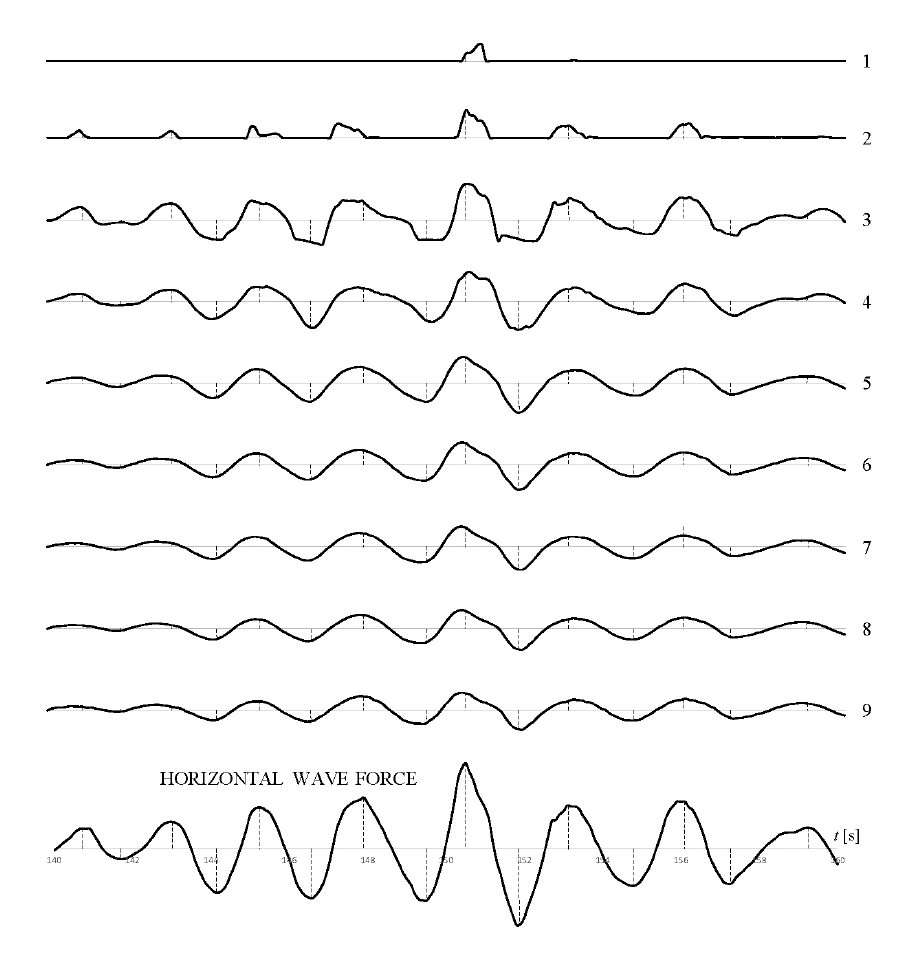
Figure 4. Wave pressure p wi , recorded at various depths on the central caisson of the U-OWC breakwater (see Figure 2a for the gauge map), and the horizontal force obtained by integrating the p wi along the front wall of the